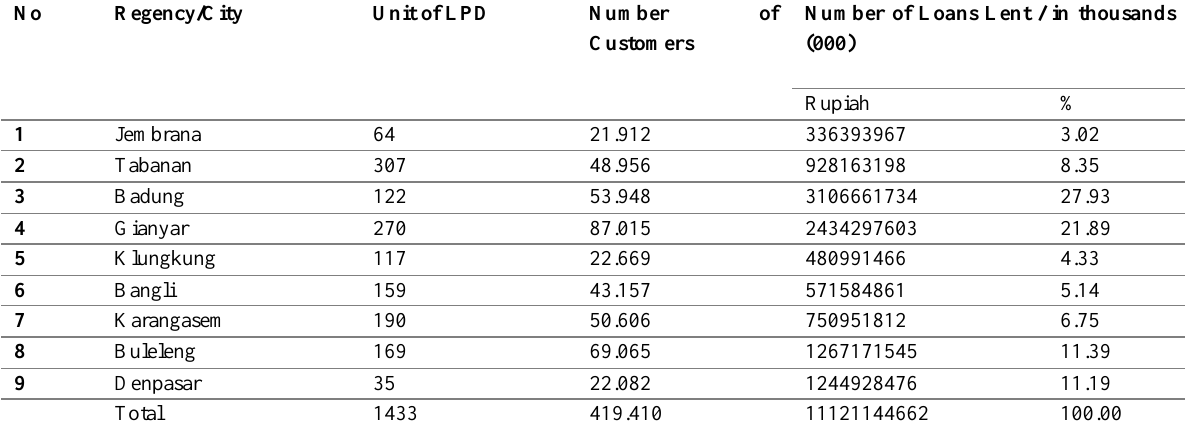
Table 2: LPD Credit Disbursement for supporting business of local people